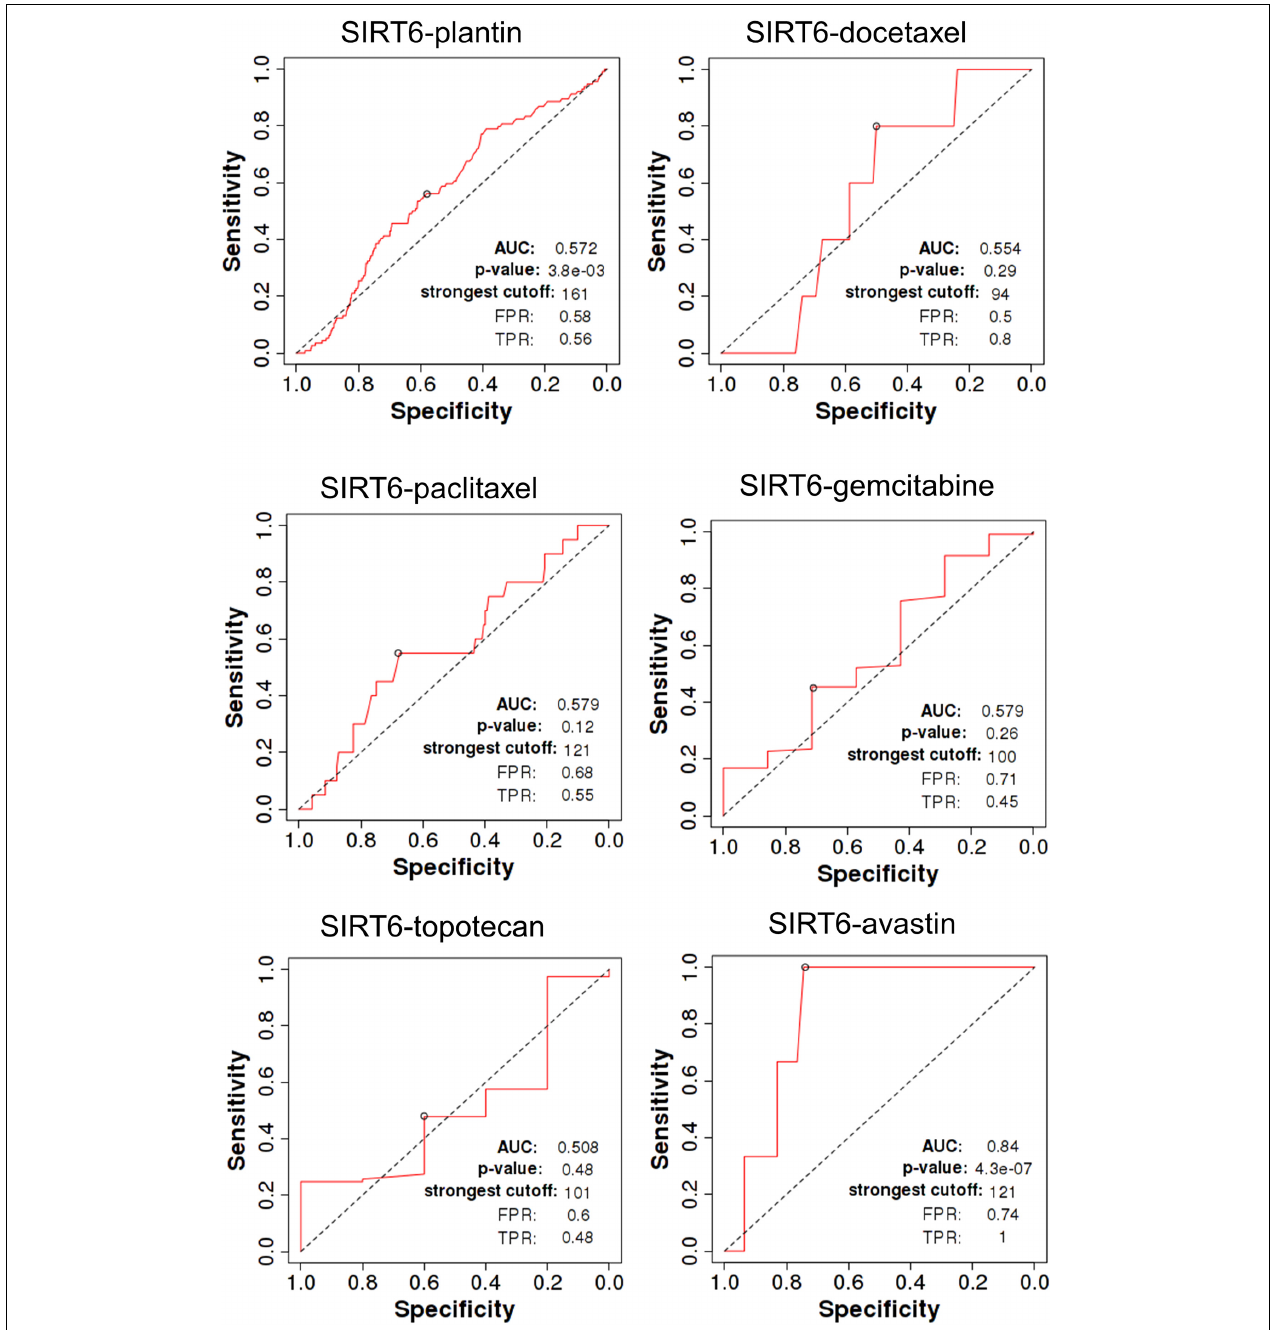
FIGURE 6 | Receiver operating characteristic (ROC) curve of SIRT6 in ovarian cancer patients under the indicated drug treatment for relapse-free survival time at 6 months. AUC, area under curve; FPR, false positive rate; TPR, true positive rate.